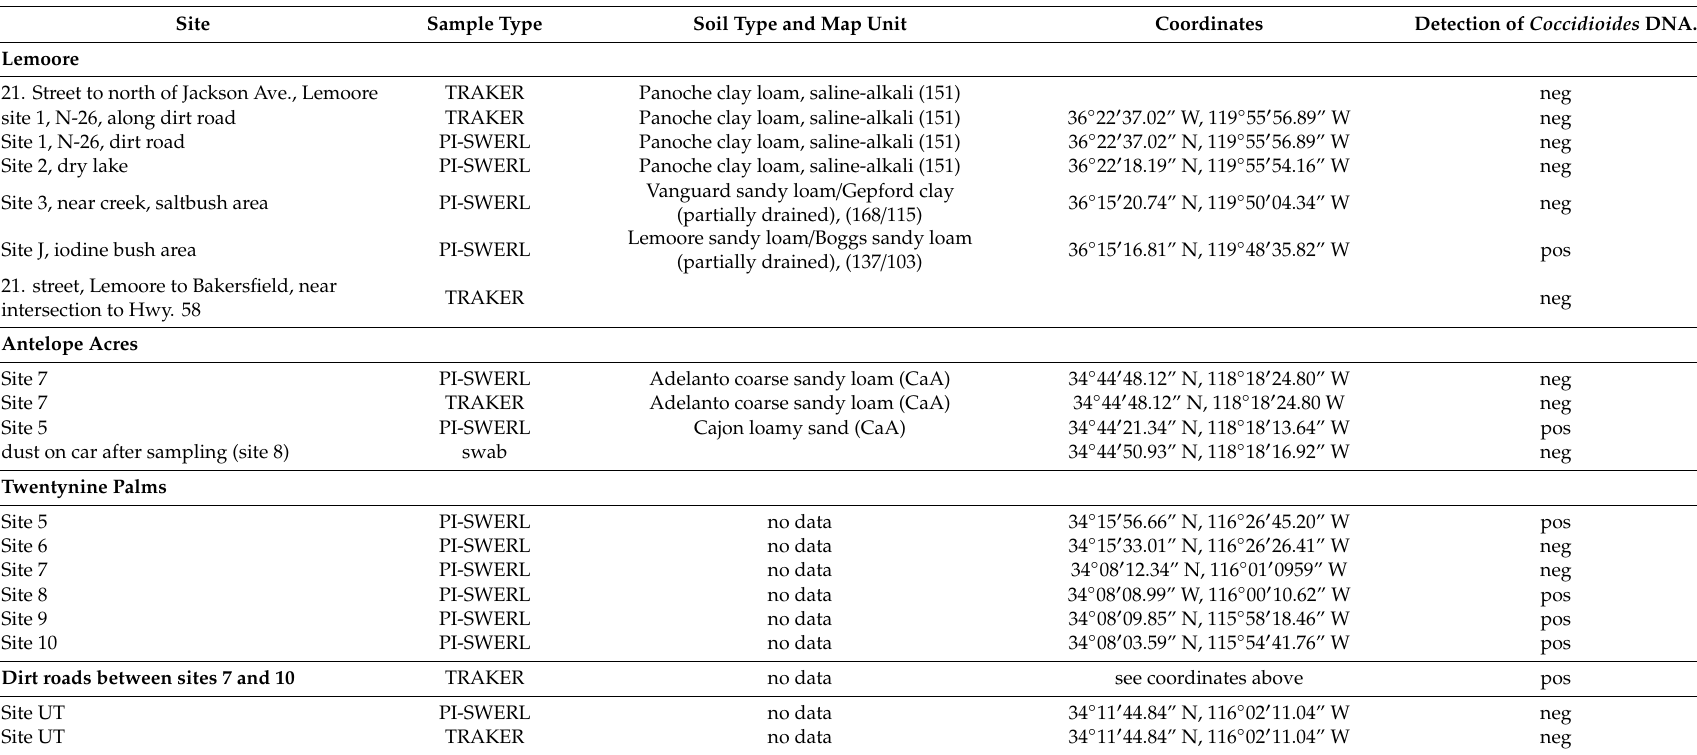
Table 6. Detection of Coccidioides DNA in wind-suspendable and vehicle-suspendable dust samples collected around NAS Lemoore, Antelope Acres (west of EAFB) and MCAGCC Twentynine Palms ( n = 13 [PI-SWERL ® ], n = 6 [TRAKER ™